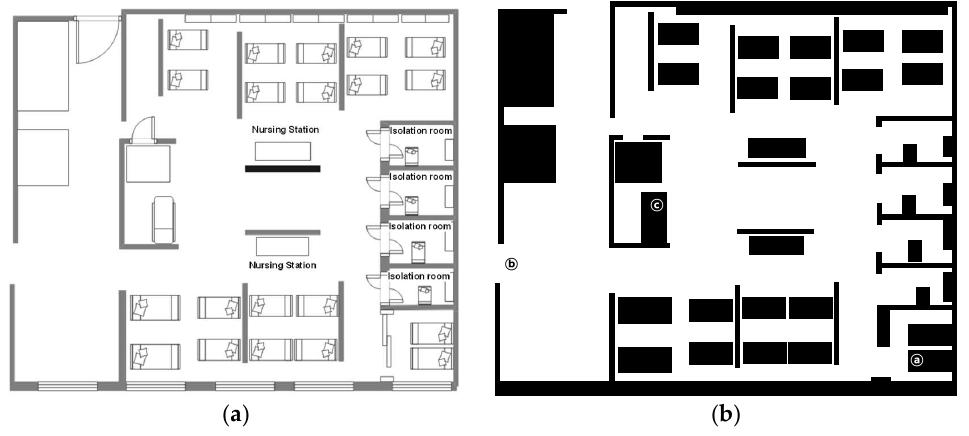
Figure 16. Simulation environment: ( a ) Hospital layout; ( b ) simplified map.